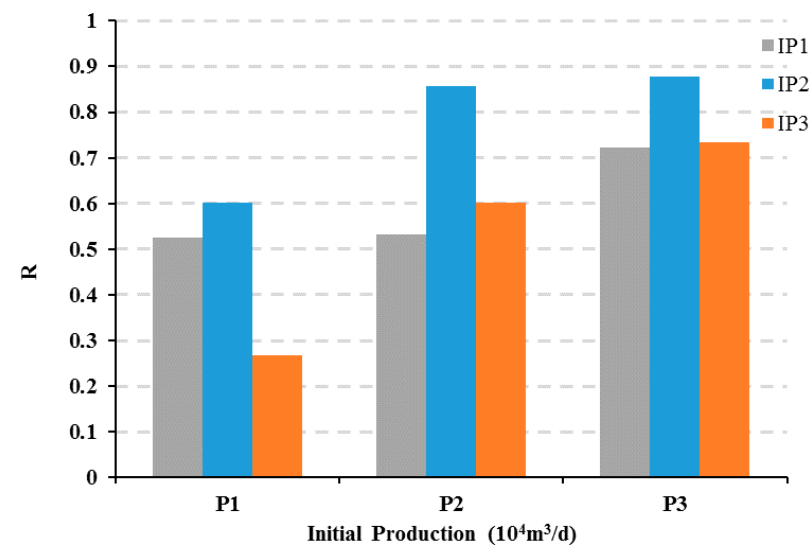
Figure 7. Correlation coefficient under different IP and price scenarios.